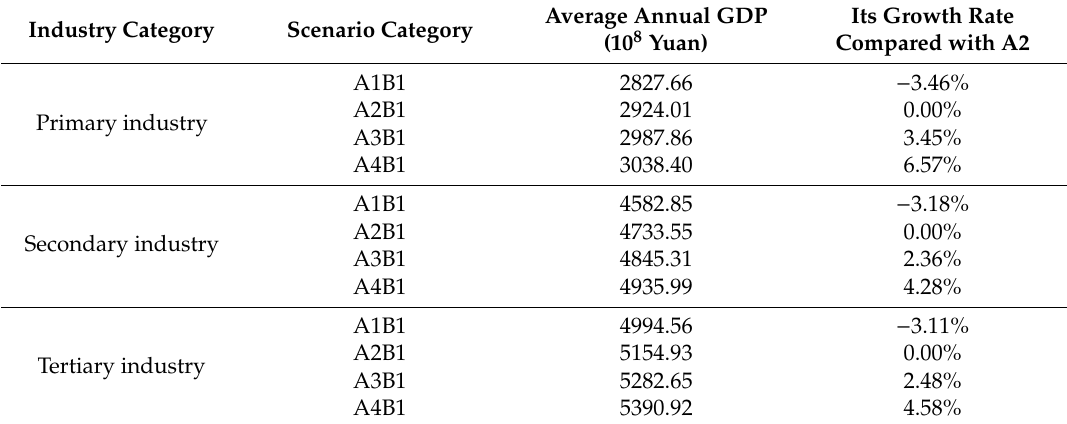
Figure 6. The simulation results of socio-economic and water impacts of 4 water diversion quantity from transboundary river basins under B1, ( a ) Primary Industrial GDP, ( b ) Secondary Industrial GDP, ( c ) Tertiary Industrial GDP, ( d ) Water Shortage. Table 6. Average annual output value of various industries and its growth rate compared with A2 under B1.